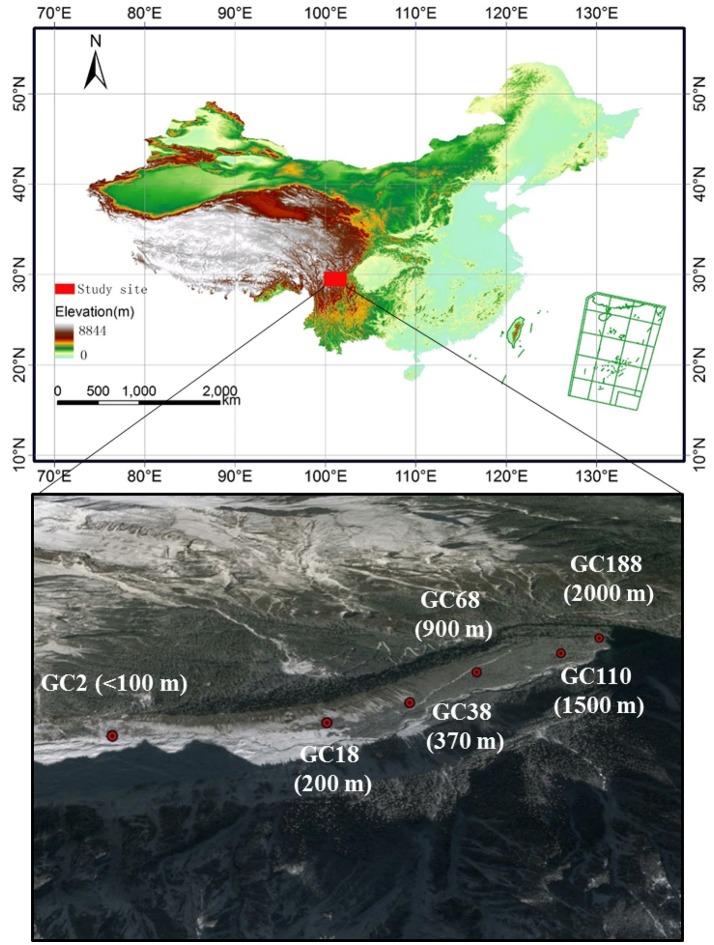
Sampling sites along the ecological succession of the Hailuogou glacier chronosequences. GC represented Glacier Chronosequence. Each stage of succession year and distance from the glacier forefield is specified by letters and a number (GC2: barren, 2 years, <100 m; GC18: 40% vegetation coverage, 18 years, 200 m; GC38, 70% vegetation coverage, 38 years, 370 m; GC68, 75% vegetation coverage, 68 years, 900 m; GC110, 85% vegetation coverage, 110 years, 1,500 m; GC188, 90% vegetation coverage, 188 years, 2,000 m). The dominant vegetation in each stage is listed in Table S1. The horizontal distance from the glacier forefield of sampling sites is in brackets.